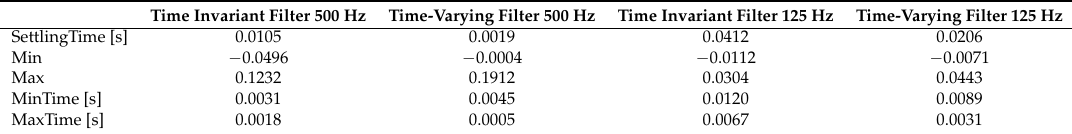
Figure 10. Second stage of the optimization routine. Exemplary middle-stage of the iterative optimization routine. Table 4. Impulse response characteristics parameters comparison of the time invariant and time-varying systems with optimization routine enabled.